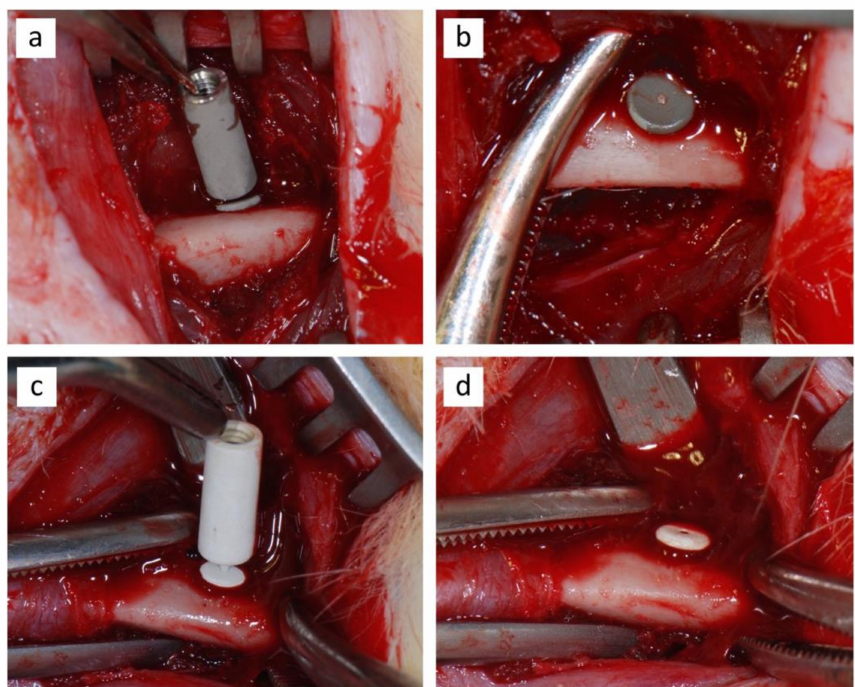
Figure 3. Surgical procedure: the positioning of the uncoated ( a ) and the sphene-coated implants ( c ) in the rats’ femurs, followed by the removal of respective carriers after the implant placement ( b , d ).